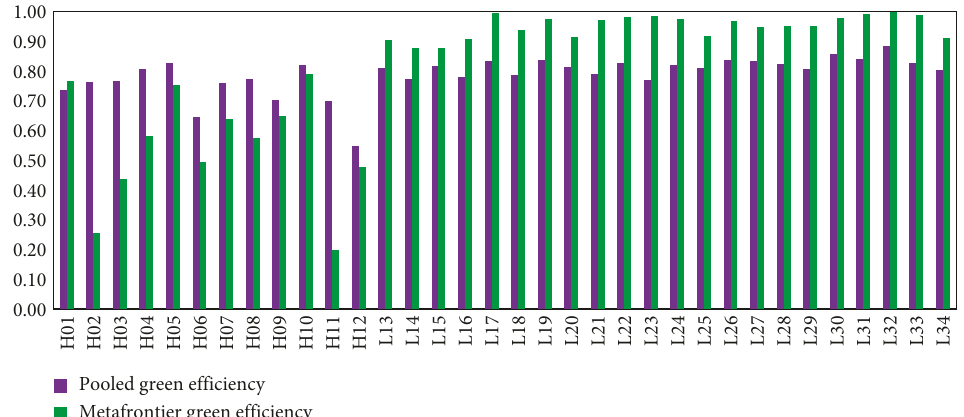
Figure 5: Comparison of metafrontier and pooled green efficiency in different